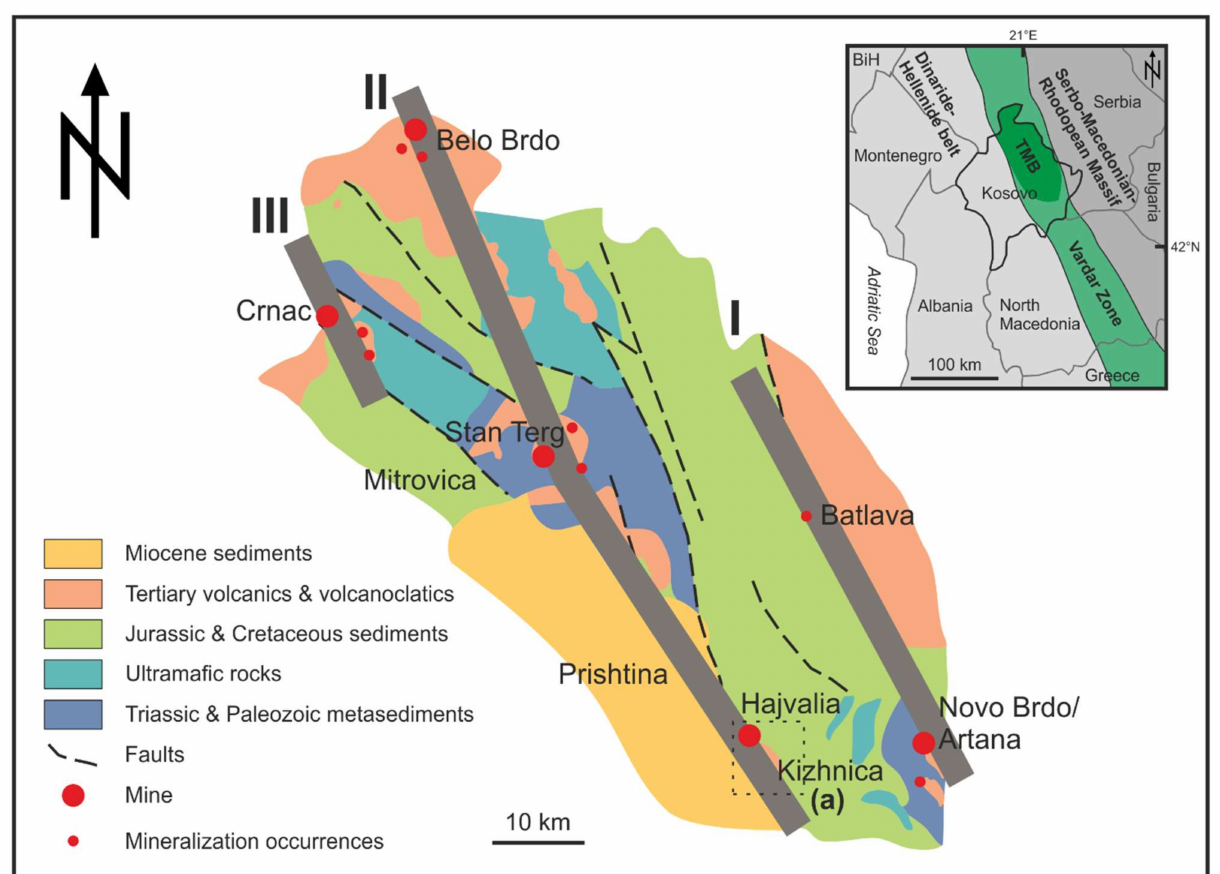
Figure 1. Simplified geological map of the Vardar Zone and the Trepça Mineral Belt (TMB), modified after [23,24]. Abbrevi- ations: I = Batlava-Artana Zone; II = Belo Brdo-Stan Terg-Hajvalia Zone; III = Crnac Zone; a = Kizhnica-Hajvalia-Badovc ore